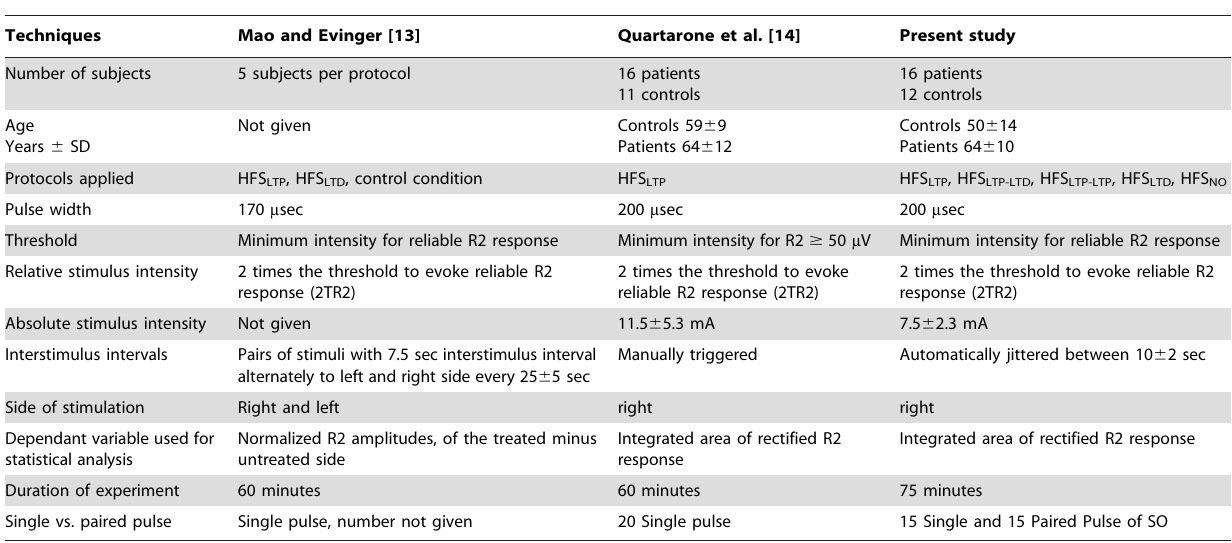
Table 4. Differences in the methods used between the experiments.